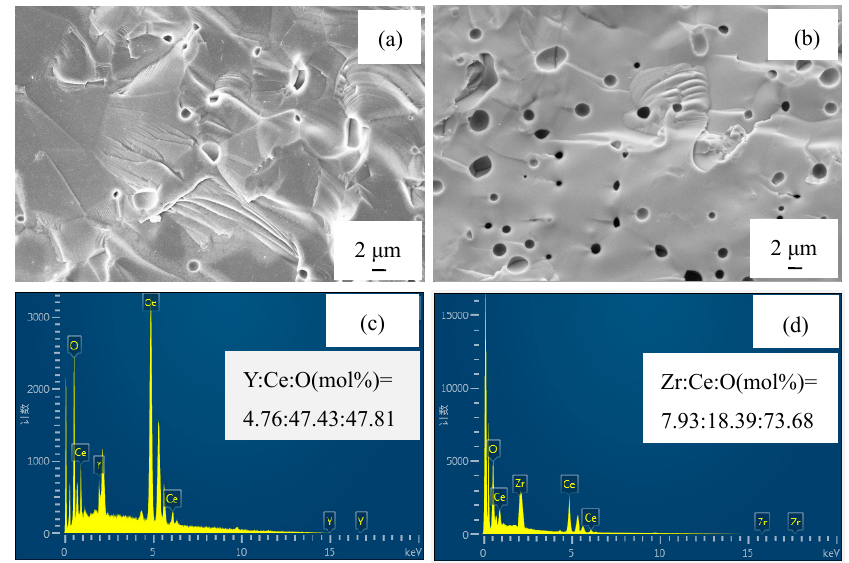
Figure 4. ( a , b ) SEM images of YDC and ZDC sintered bodies, ( c , d ) elemental distributions of YDC and ZDC.